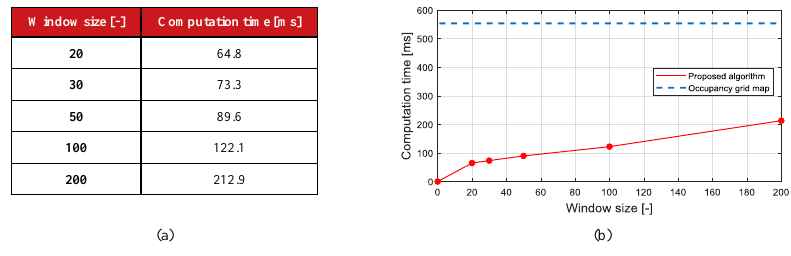
Figure 12. ( a ) table and ( b ) plot of Computation time for the occupancy grid map and the proposed